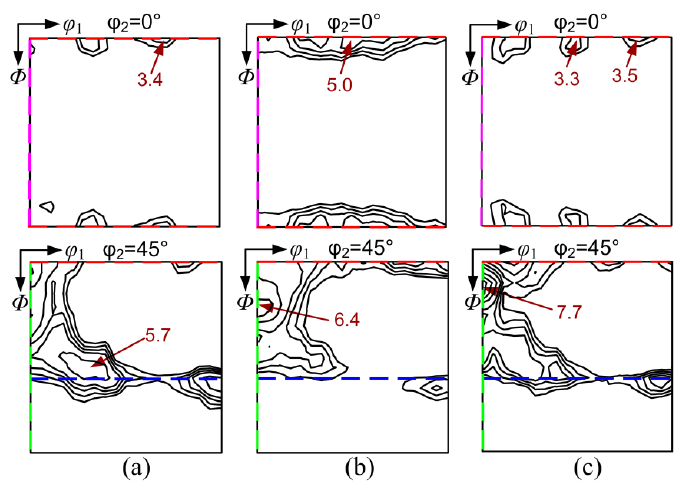
Figure 9. Second cold rolling textures of ( a ) TCR9 sample; ( b ) TCR10 sample and ( c ) TCR11 sample.